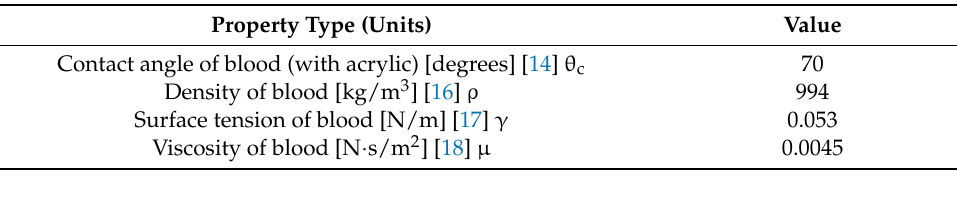
Table 2. Properties of the whole blood used in the FEA simulation describing the separation and isolation of the red blood cells in the RBC chamber.